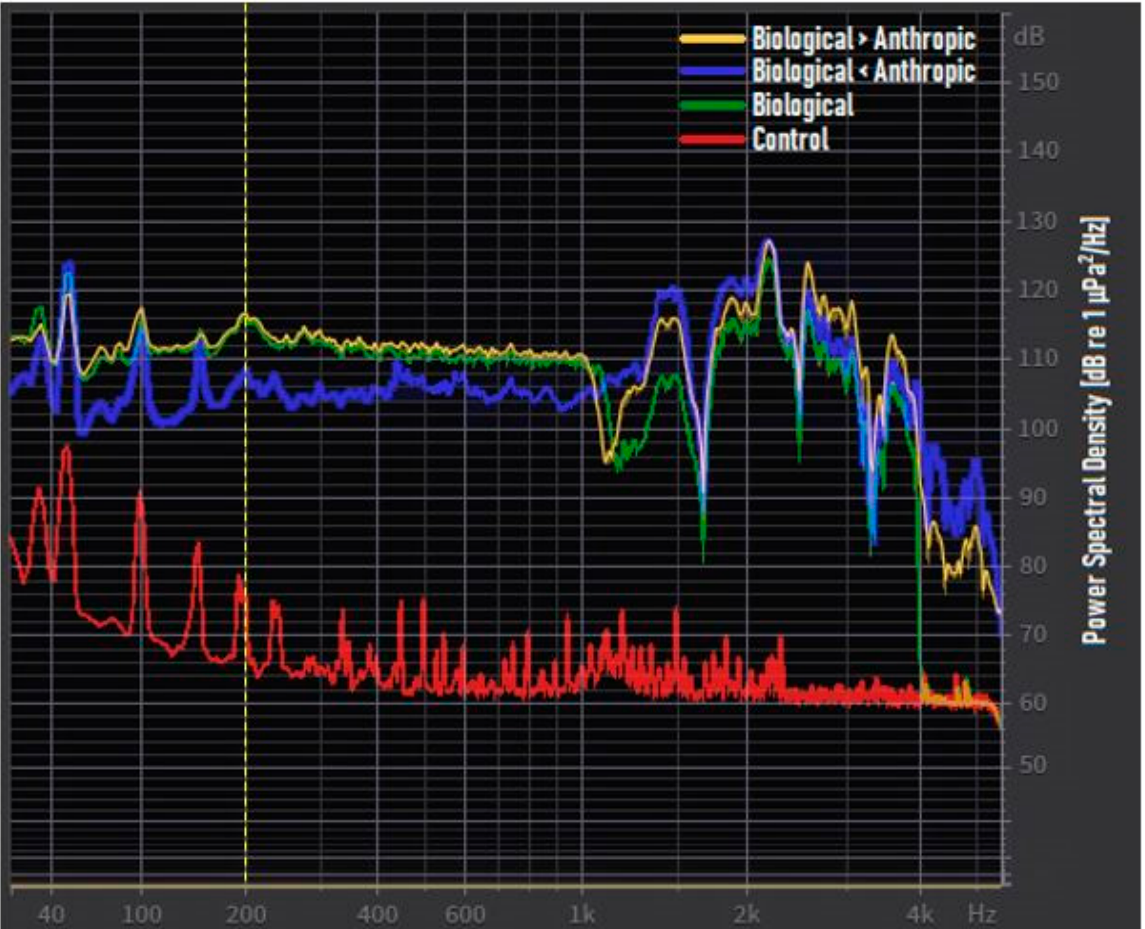
Figure 2. Averaged power spectrum of the three audio-created acoustic tracks and the aquarium’s background noise. The power spectral density (PSD) is expressed in dB re 1 µPa2/Hz versus the logarithmic frequency scale expressed in Hz. The yellow dotted line represents the limit below which the sound speaker has a limited frequency response.